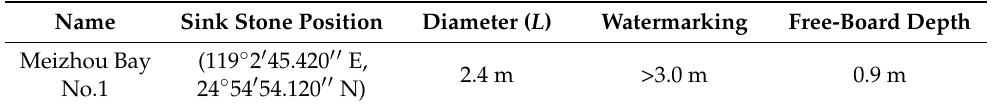
Table 6. Simulation of buoy parameters.